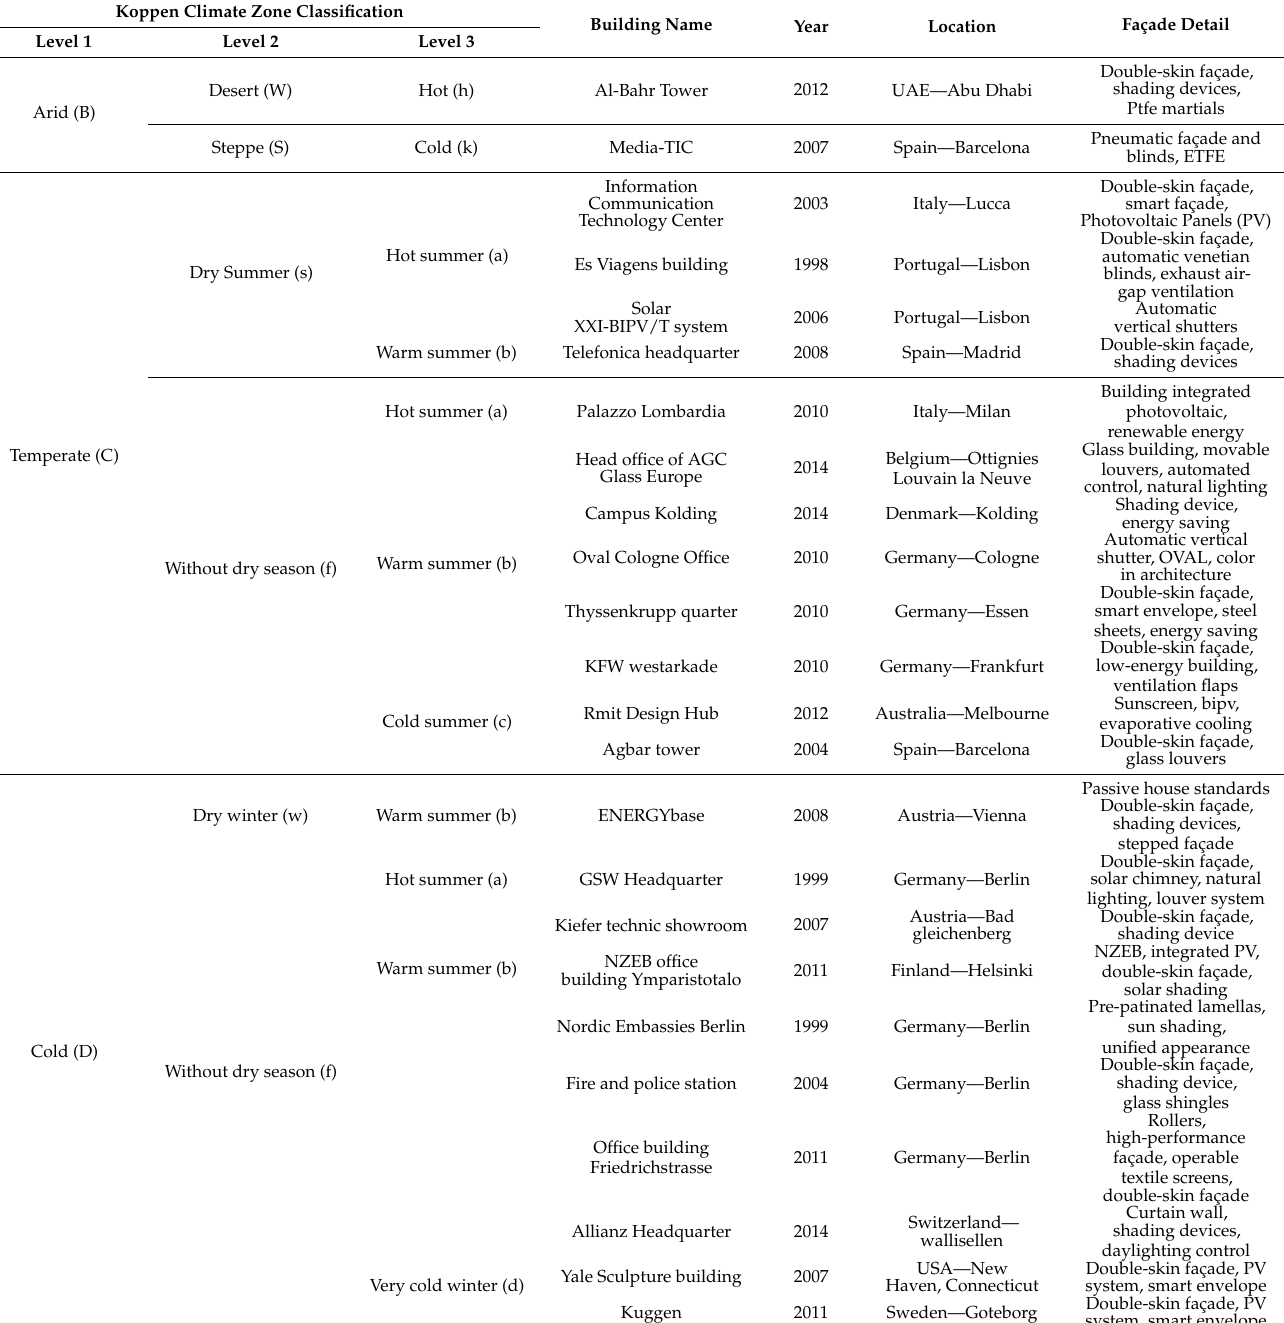
Table 3. Phase I—façade details of CABS office buildings classified based on Koppen Climate Zones Classification [30,31], amended by the authors,